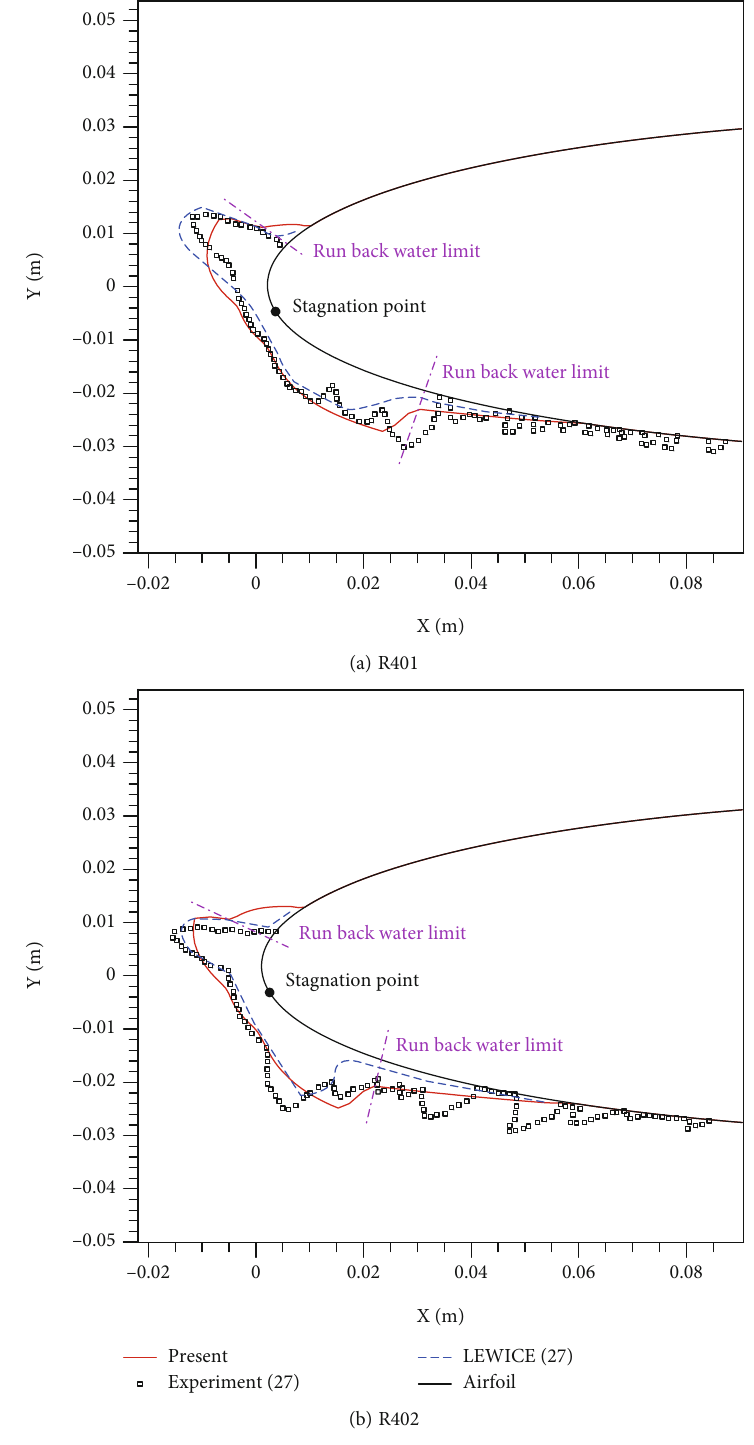
Figure 3: Comparisons of the ice shapes with the literature data for mixed rime-glaze